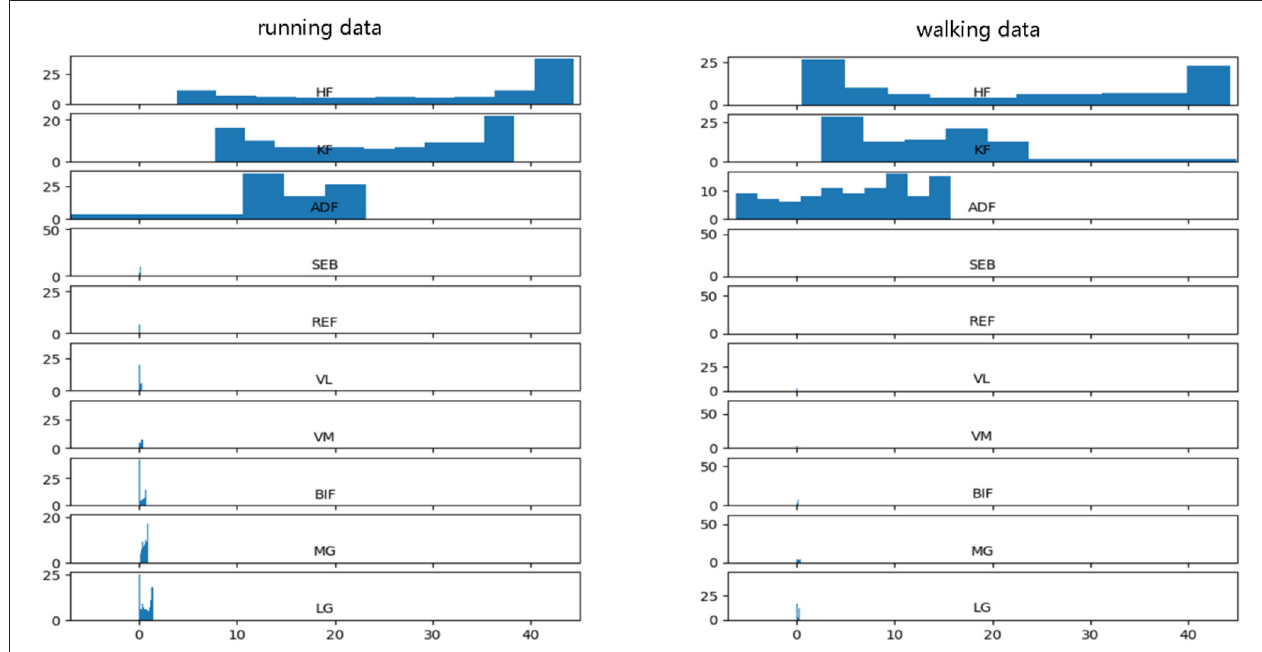
FIGURE 2 | Raw data distribution in the walking and running